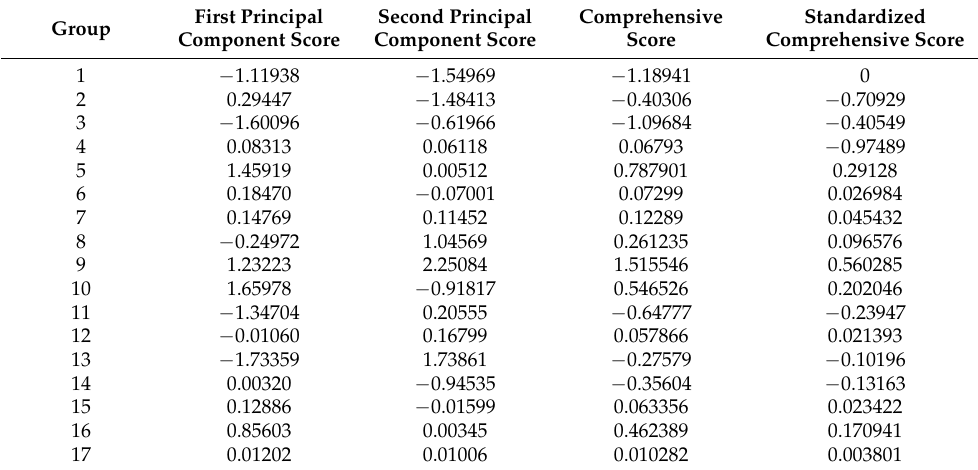
Table 9. Principal component score and standardized comprehensive